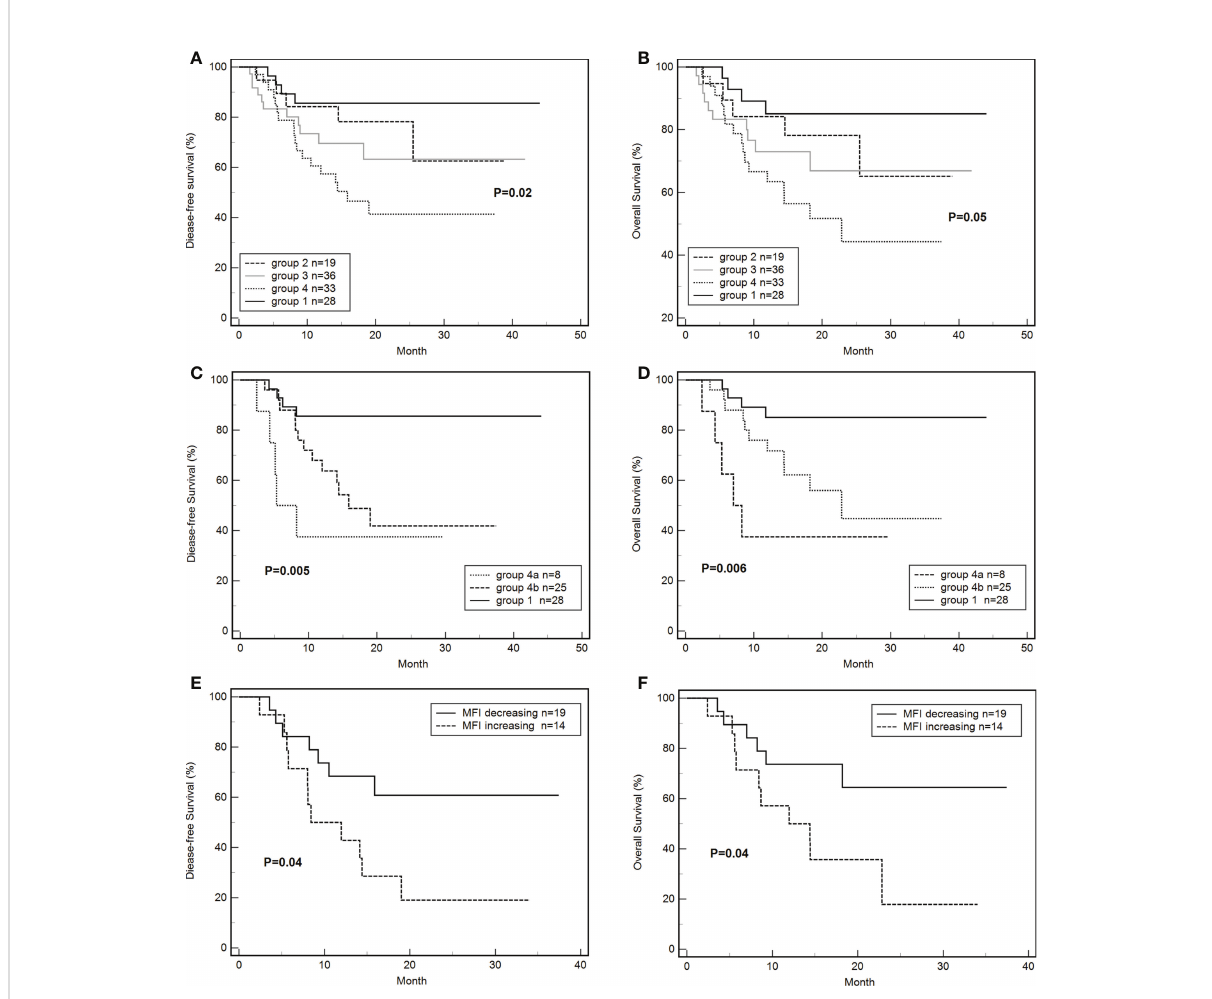
FIGURE 4 Effects of de novo HLA antibody, persistent de novo HLA antibody, and changes in MFI on DFS and OS. (A) Effects of de novo HLA antibodies in four groups on DFS. (B) Effects of de novo HLA antibodies in four groups on OS. (C) Effects of persistent de novo antibodies on DFS. (D) Effects of persistent de novo antibodies on OS. (E) Effects of MFI level changes of de novo antibodies on DFS. (F) Effects of MFI level changes of de novo antibodies on OS.